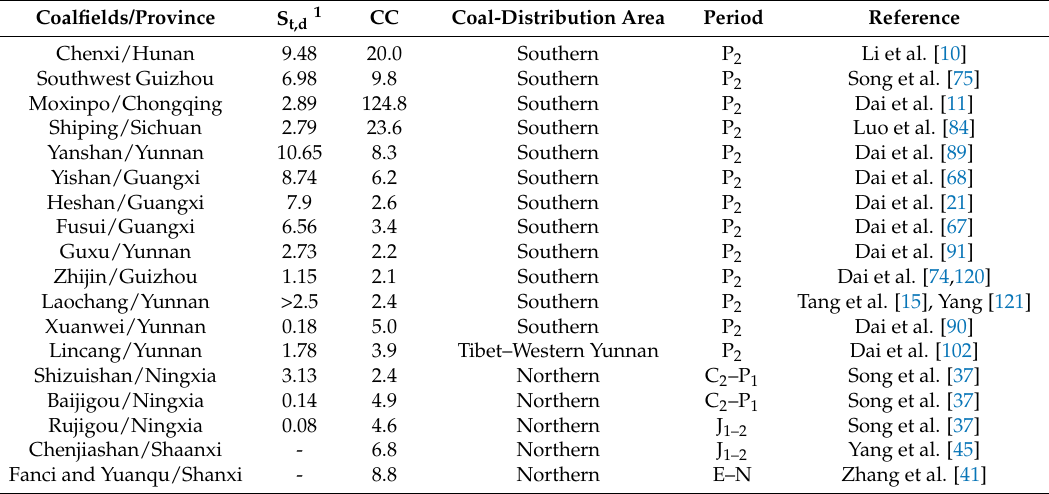
Table 8. Coalfields with appreciable content of cadmium (CC >